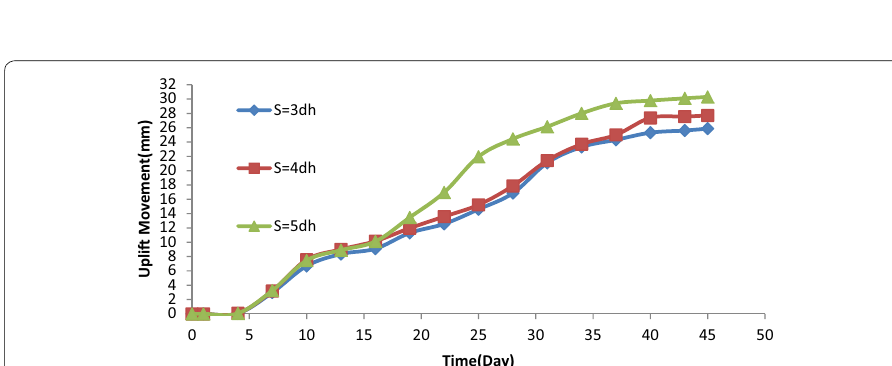
Fig. 22 Variation of uplift movement with time for pile group of L/D